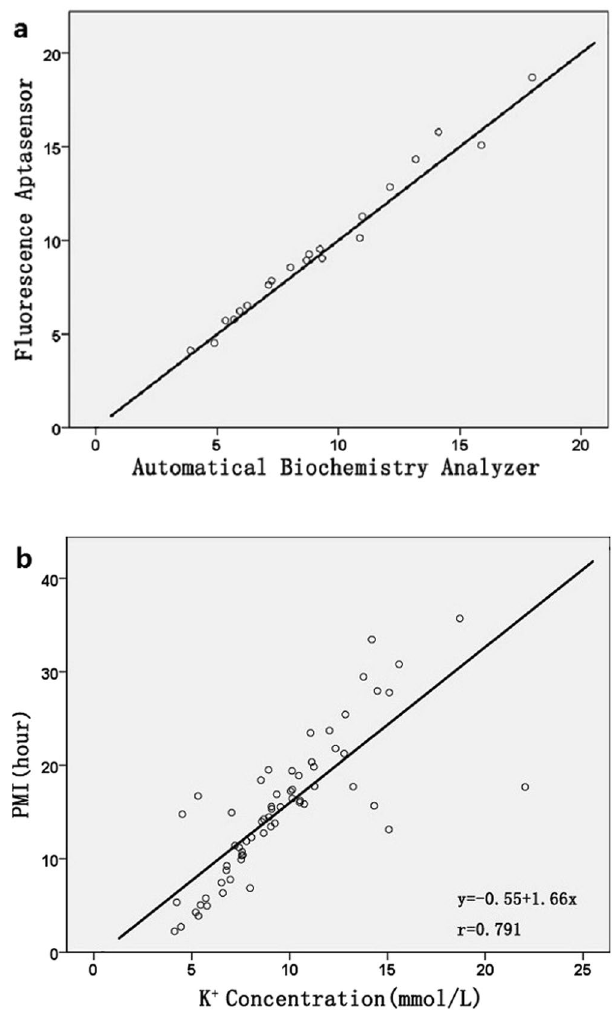
Figure 6. ( a ) Correlation between the fluorescence aptasensor and the automatic biochemistry analyzer. ( b ) Linear regression graph showing correlation between PMI and postmortem vitreous potassium.